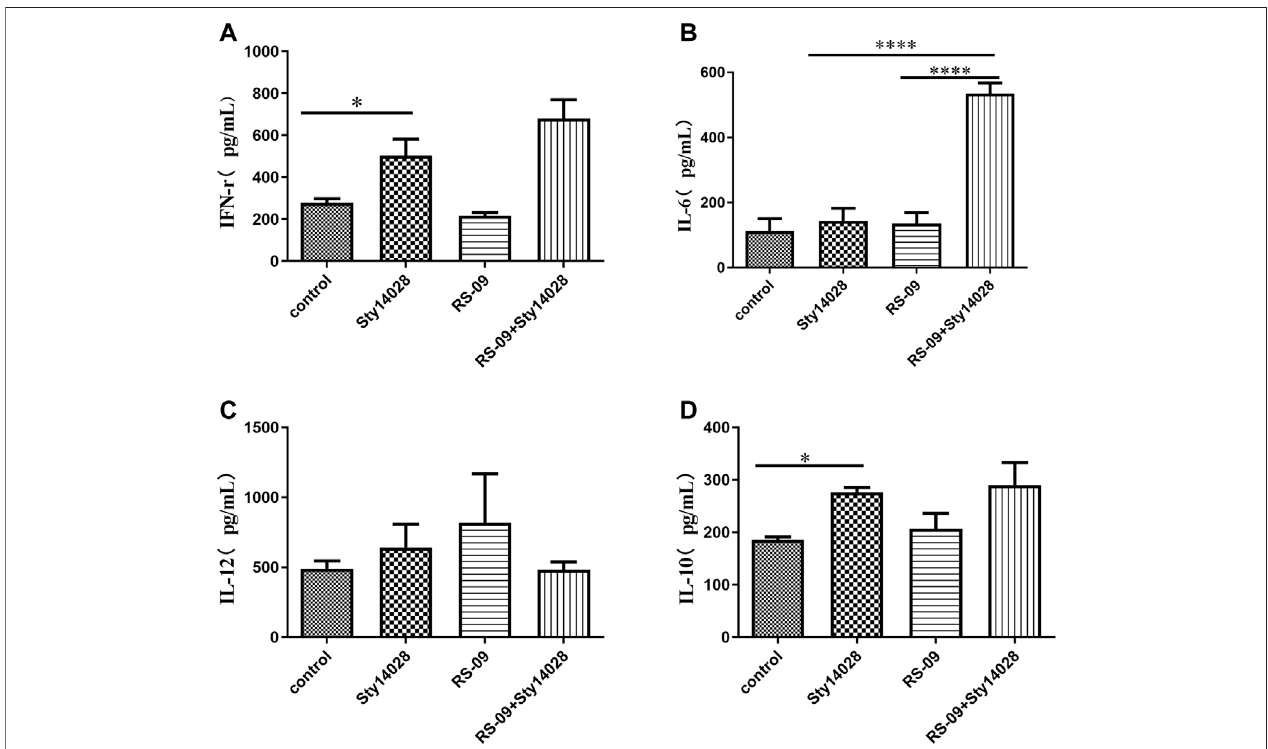
FIGURE 5 | RS-09 modulates cytokine production in mice challenged with pathogenic S . Typhimurium. RS-09 (5 × 10 9 CFU/mouse) was orally administered to micefor 7 days, and they were then orally administered a sublethal dose of Sty14028 suspension (10 5 CFU/mouse). At 8 d postinfection, serum was collected from the blood to evaluate the expression of (A) IFN- γ , (B) IL-6, (C) IL-12 and (D) IL-10. The data are the means ± SD (n = 3). p values were calculated by ANOVA. * p < 0.05; **** p <